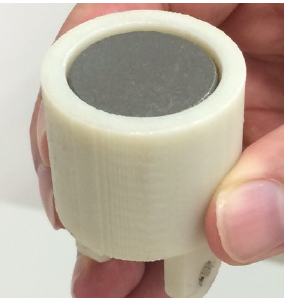
Figure 9. 1 mm gap left in magnet